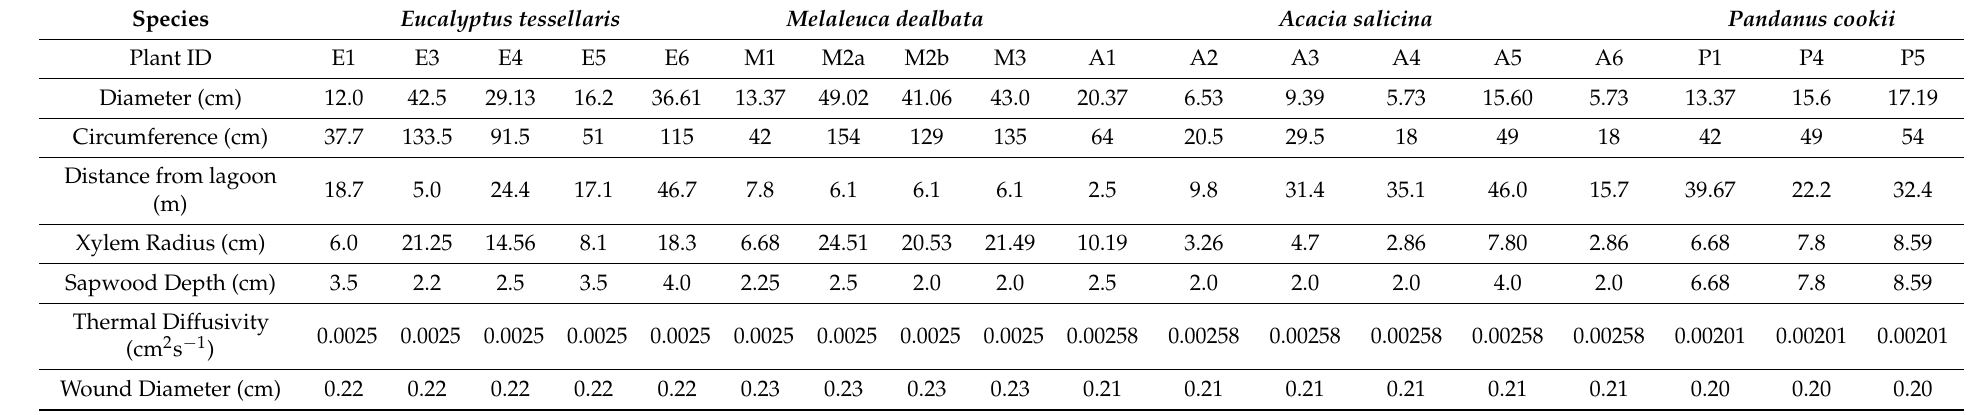
Table 1. Characteristics of the monitored trees and sap flow rates for each